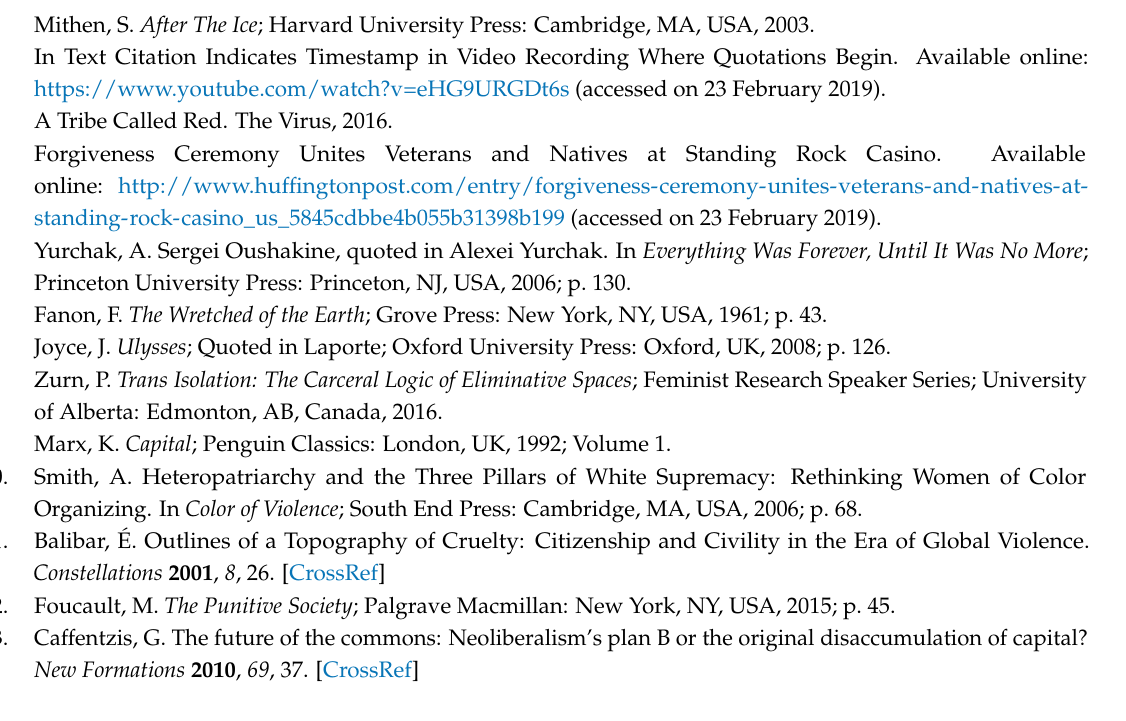
Figure A2. Layout of the excavated enclosures at Göbekli Tepe. The top image in Figure A1 is of one of the central pillars from enclosure D (circled; enclosure D is the oldest, to date). (Researchgate)